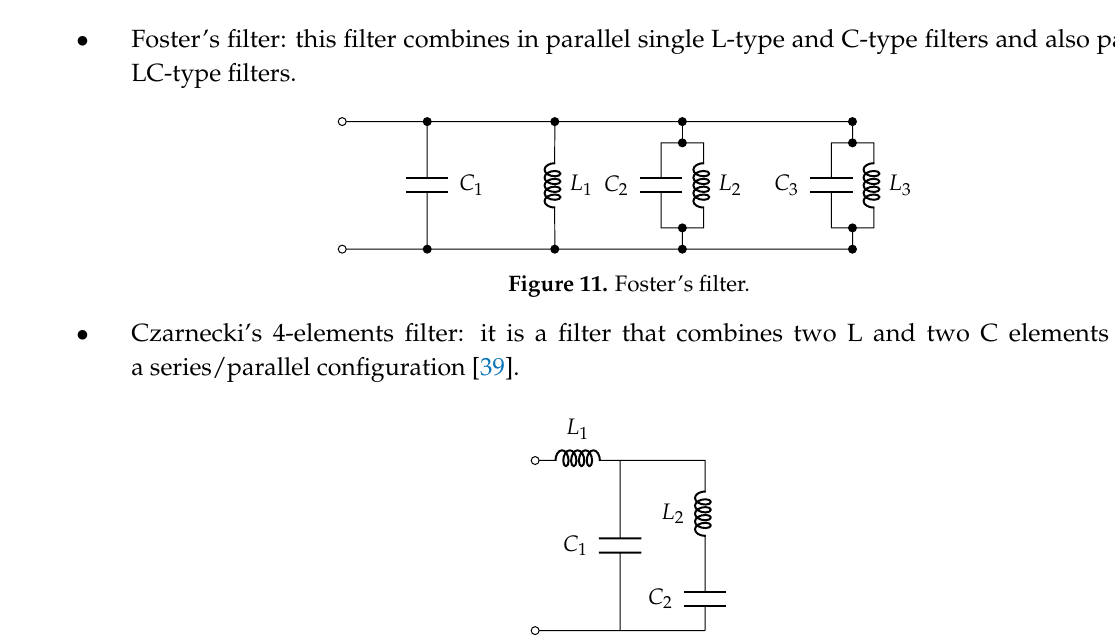
Figure 12. Czarnecki’s 4-elements filter.